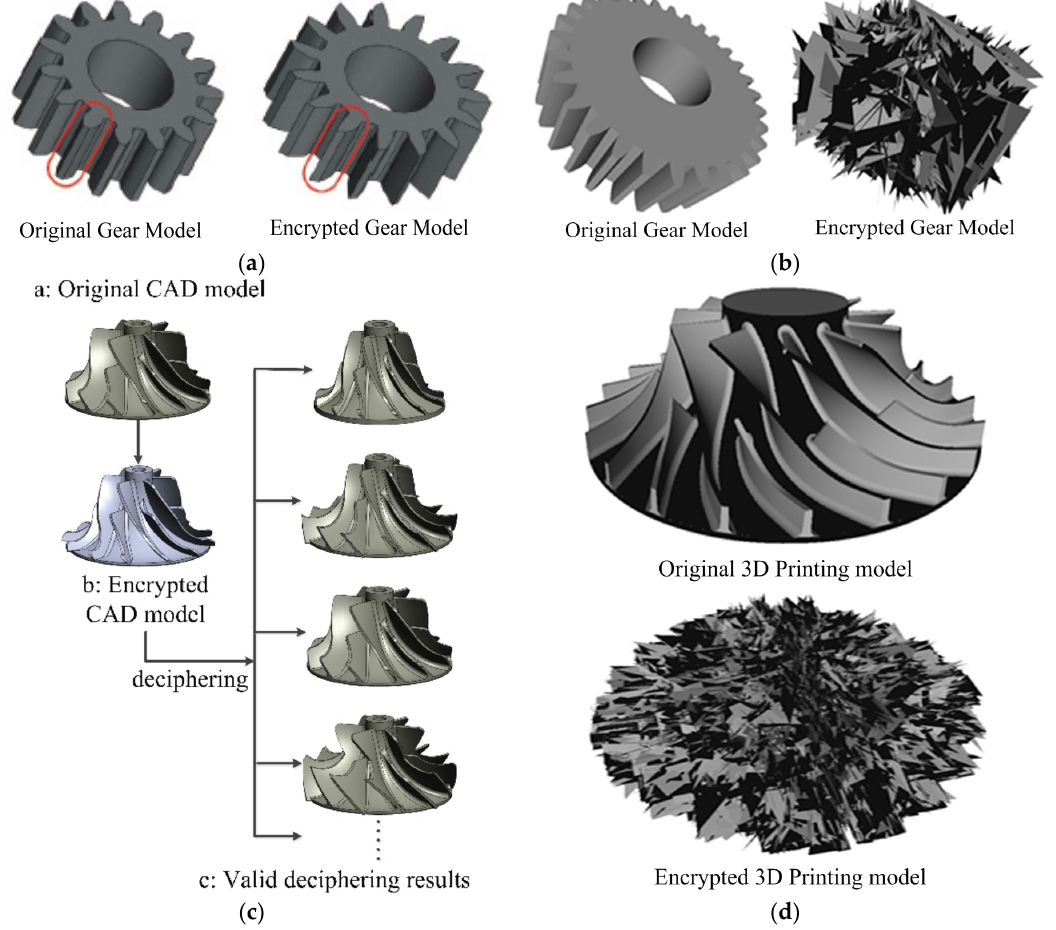
Figure 6. Perceptual encryption results of our proposed method and Cai’s method. ( a , c ) Results of Cai’s method; ( b , d ) results of the proposed method.